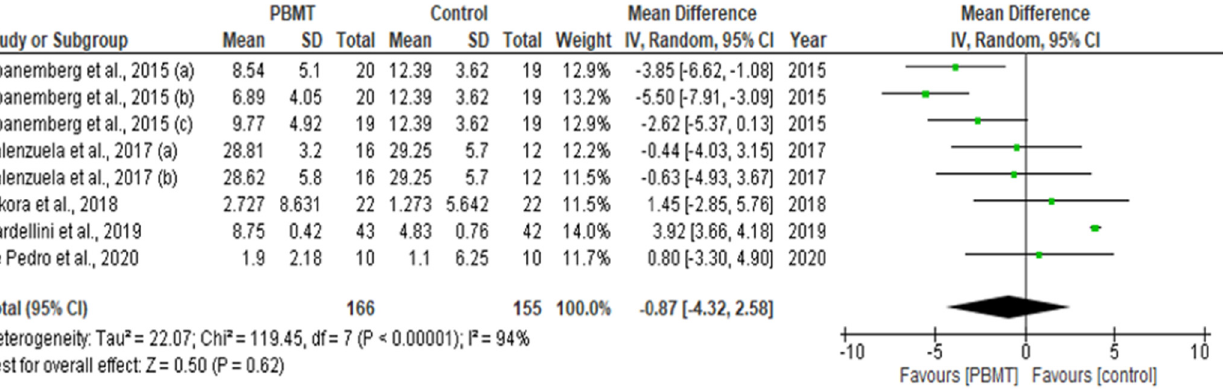
Figure 7. Funnel plot summary for primary outcome qualitative pain/burning sensation reduction assessment (VAS) from baseline up to the final follow-up timepoint.